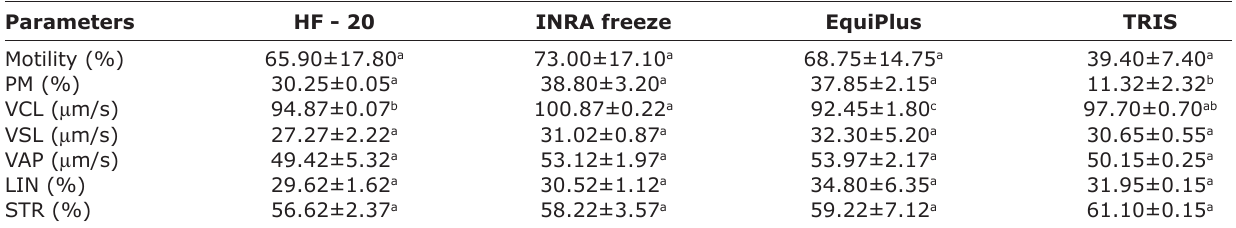
Table-2: Effect of different extenders on chilled stallion semen after 90 min on the motility pattern.